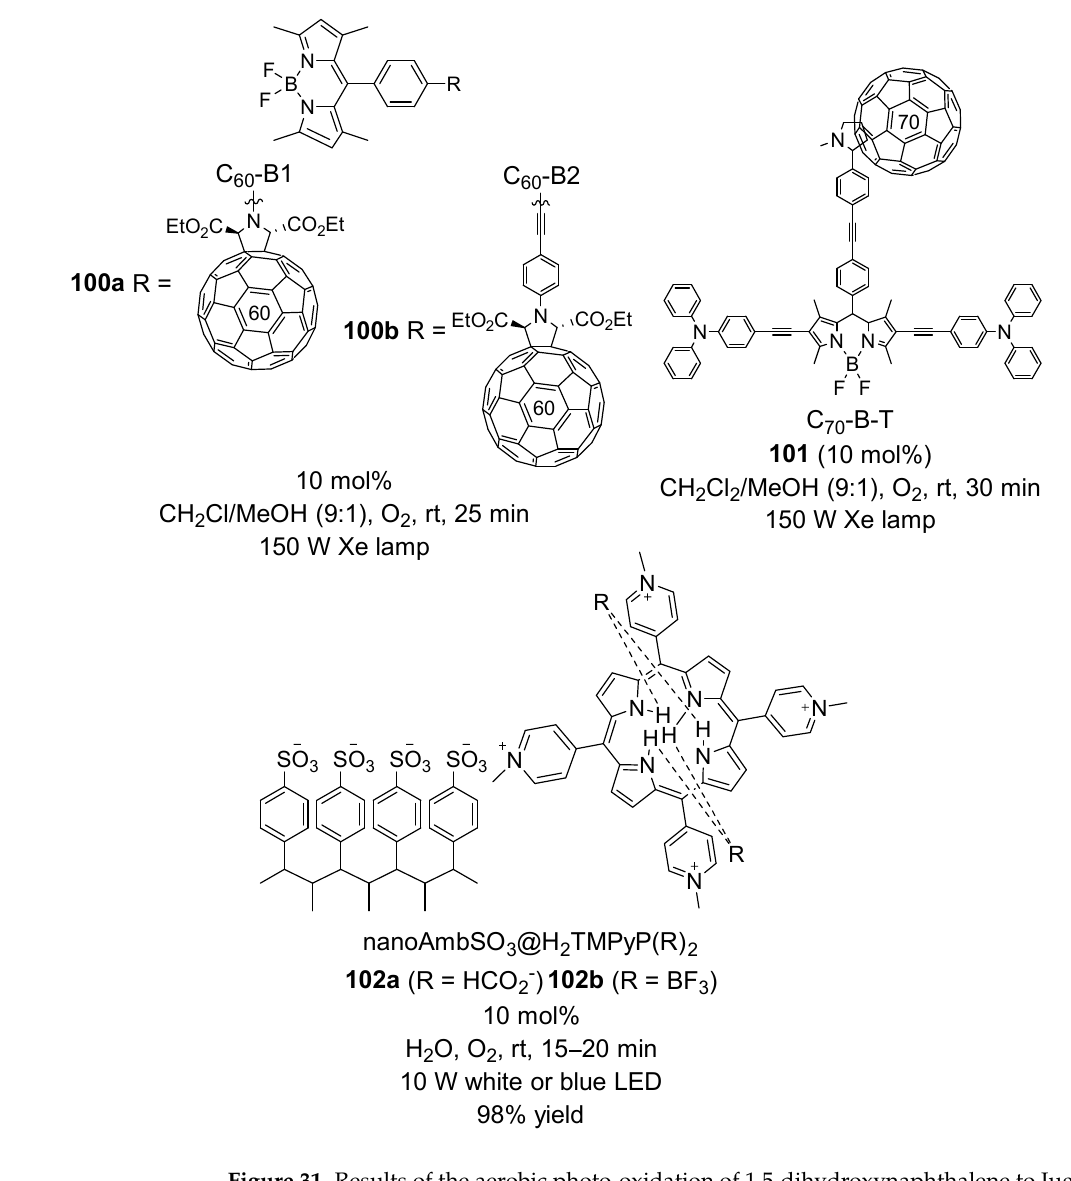
Figure 31. Results of the aerobic photo-oxidation of 1,5-dihydroxynaphthalene to Juglone ( 85 : R 1 = R 2 = R 5 = H, R 4 = OH) catalyzed by 100 – 102 .